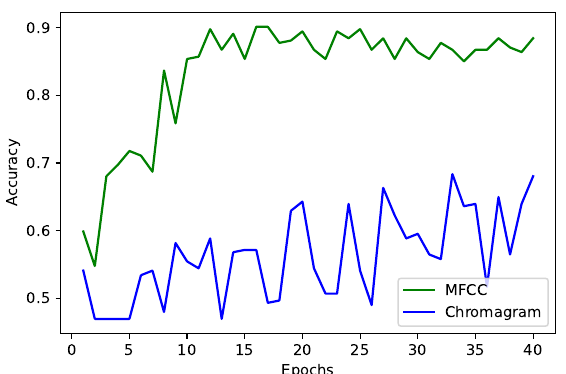
Figure 12. Validation accuracy of the proposed approach with different feature